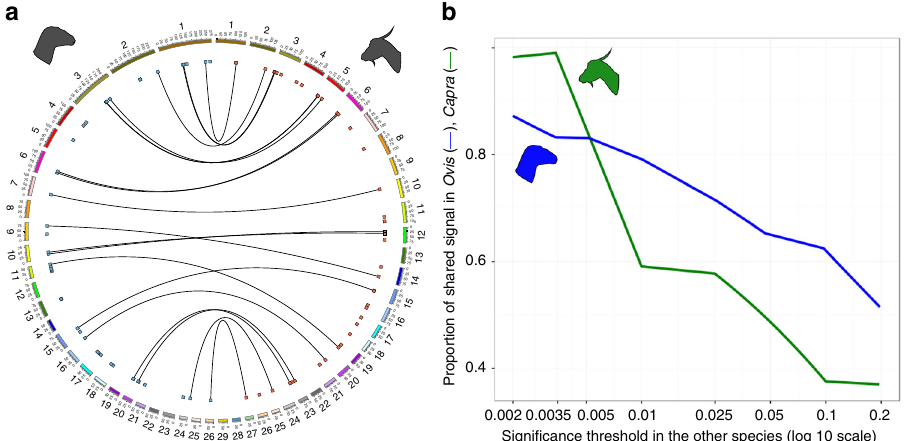
Fig. 2 Speci fi c and shared chromosomal regions selected during domestication. a Circular representation of the sheep (left) and goat (right) genomes. Dots represent regions under selection, lines indicate shared selected regions. Chromosomes sizes are in Megabases. b Convergence in the signals of selection between Capra and Ovis . In homologous genomic regions, the proportion of signi fi cant SNPs found under selection in Ovis , respectively Capra ( y -axis), increases with the stringency for detecting selection in Capra , respectively Ovis ( x -axis)